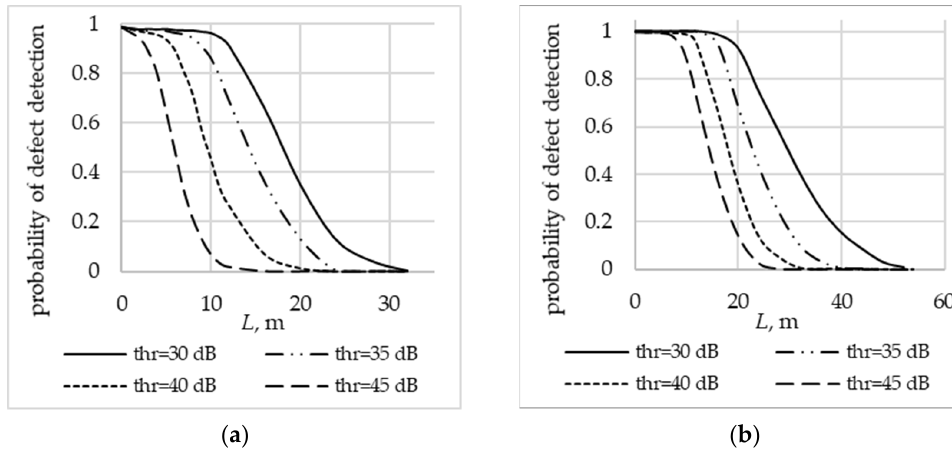
Figure 14. The probability of detection of a fatigue crack for steels 09G2S ( a ) and 45 ( b ).